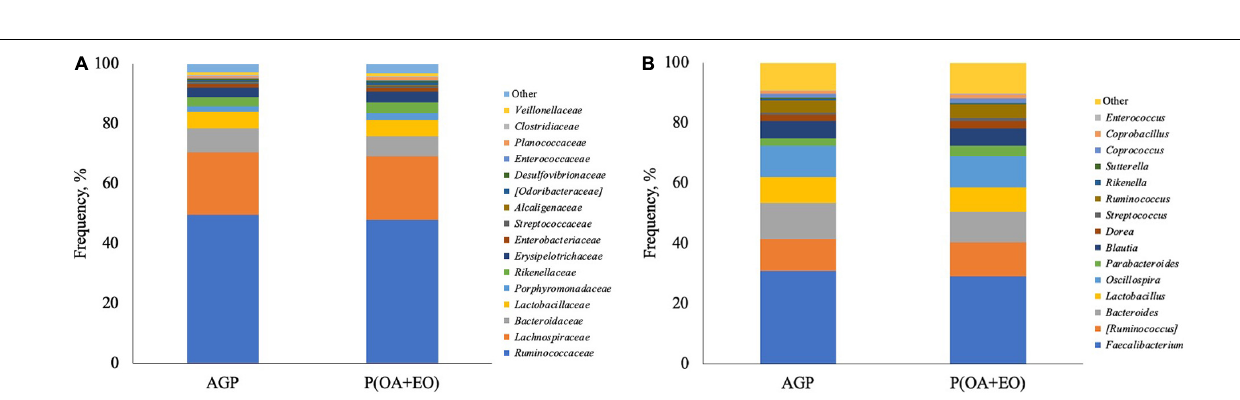
FIGURE 4 | Composition of the cecal microbiota at family (A) and genus (B) level of broiler chickens supplemented with antibiotic growth promoter (AGP) or protected organic acids (OA) and essential oils (EO) [P(OA + EO)] raised under field conditions. Values are means of 40 replicates.